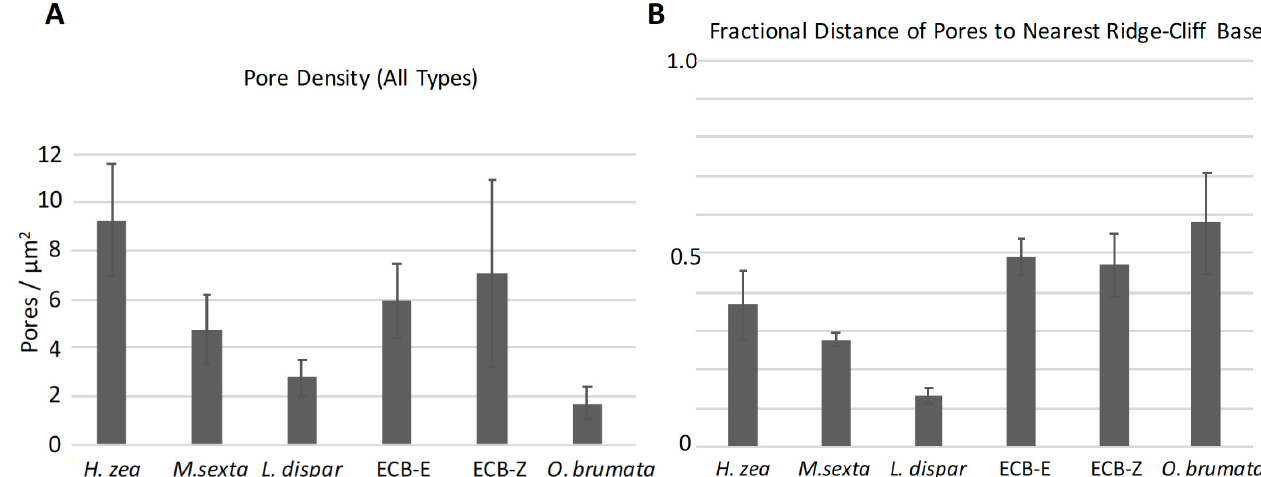
Figure 12. Mean pore densities ( A ) and the mean fractional distances of pores from nearest proximal ridge-cliffs ( B ) on the trichoid sensilla of five moth species. All measurements were performed on the middle regions of the sensilla. The labels, “ECB-E” and “ECB-Z”, refer to the E - and Z -strains, respectively, of Ostrinia nubilalis . Error bars denote standard deviations. ( A ) N = 11, 8, 12, 10, 10, and 10 densities for Helicoverpa zea , Manduca sexta , Lymantria dispar , O. nubilalis E -strain, O. nubilalis Z -strain, and Operophtera brumata , respectively. ( B ) N = 14, 19, 16, 7, 10, 10, and 10 for these same species.